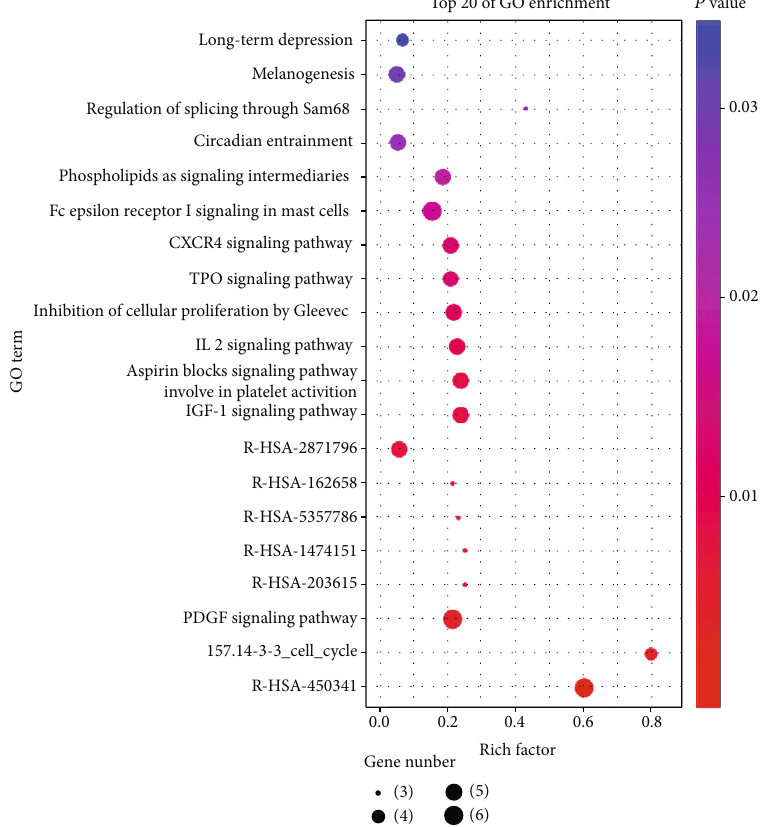
Figure 5: Top 20 of pathway enrichment. The circle size stands for gene numbers, the red color and higher rich factor indicate greater enrichment of